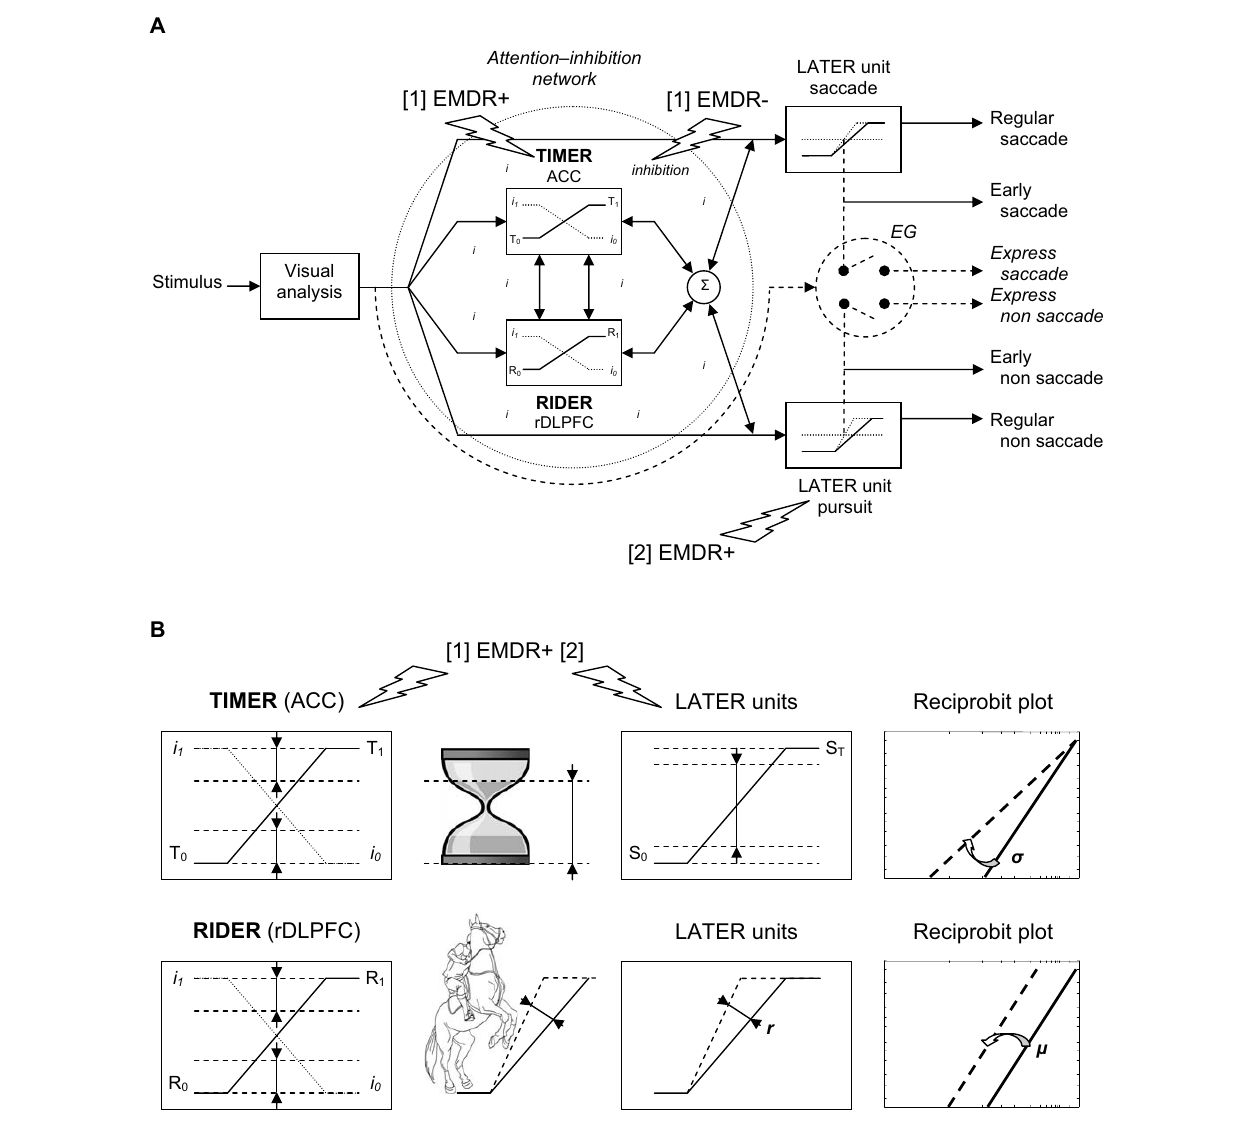
FIGURE 2 | (A) TIMER/RIDER model . Visual information from the two retinas is analyzed to determine the spatial location of the stimulus. Excitatory mechanisms (right). Once the decision is made to elicit an eye movement toward the stimulus, decision signals initiate in LATER units for saccade and non saccade, which rise at a constant rate to reach the threshold at which regular or early saccade and/or non saccade are triggered. In LATER units, the thresholds and/or the rates of rise for saccade and non saccade can differ. Inhibitory mechanisms (dotted circle). In a global attention-inhibition network, the